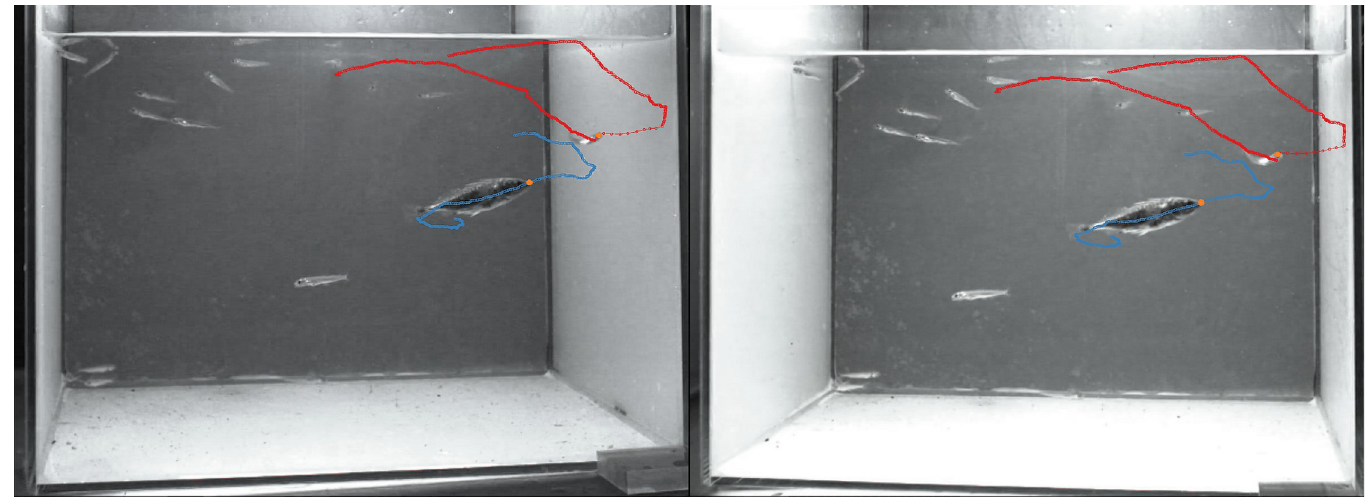
Fig 2. 2D stereo tracking. Manual tracking analysis with Argus of left and right camera recording; tracking points: eye of the larvae (red), snout-tip of the stickleback (blue), tracking period: first hunt over 700 frames (5 s). Here the whitefish larva escaped. The setup partially mimics the pelagic situation of Lake Constance.